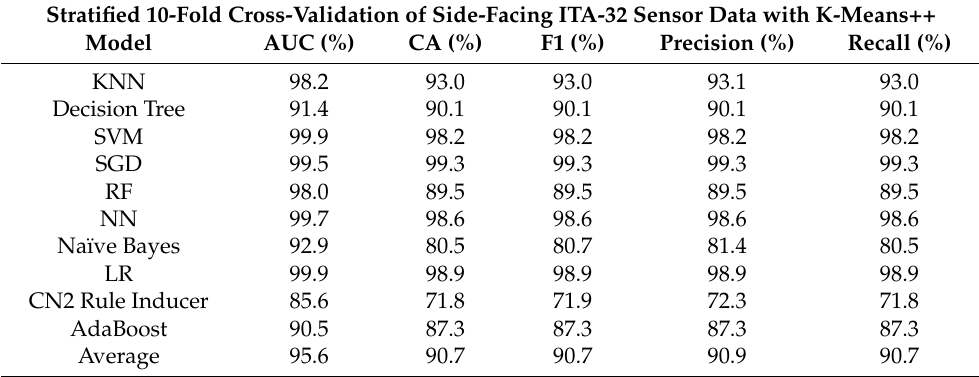
Table 2. Evaluation results showing the accuracies of data mining models during Classification-by-Clustering of a set of sprained ankle rehabilitation exercises data using K-Means++ Algorithm (KMA).